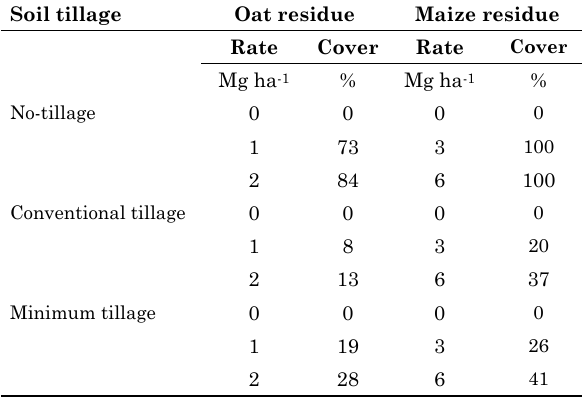
diverse rates of oat and maize residue Soil tillage Oat